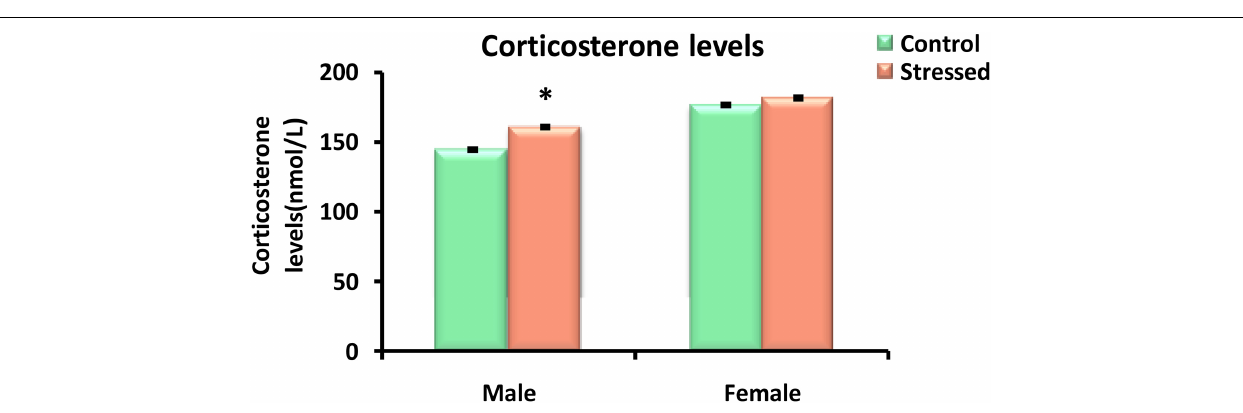
Frontiers in Physiology |